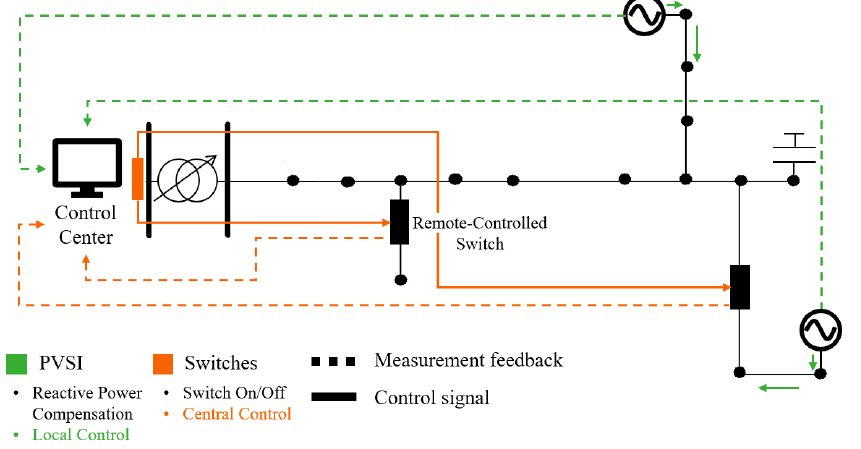
Figure 1. System